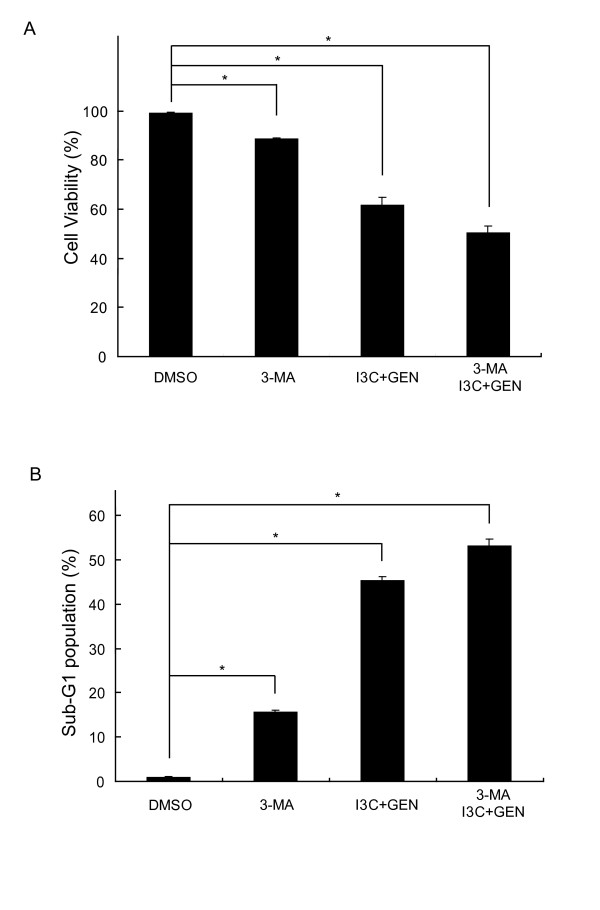
3-MA does not inhibit the cell death caused by co-treatment with I3C and genistein. Cell viability (A) and the sub-G1 population (B) in the HT-29 cells exposed to DMSO, 3-MA (10 mmol/L) or the co-treatment with I3C (300 μmol/L) and genistein (40 μmol/L) with or without 3-MA (10 mmol/L) for 48 h. Cell viability and the sub-G1 population were analyzed as described in Materials and Methods. Columns, mean (n = 3); bars, SD. *, P < 0.05, significantly different compared with the DMSO-treated control.